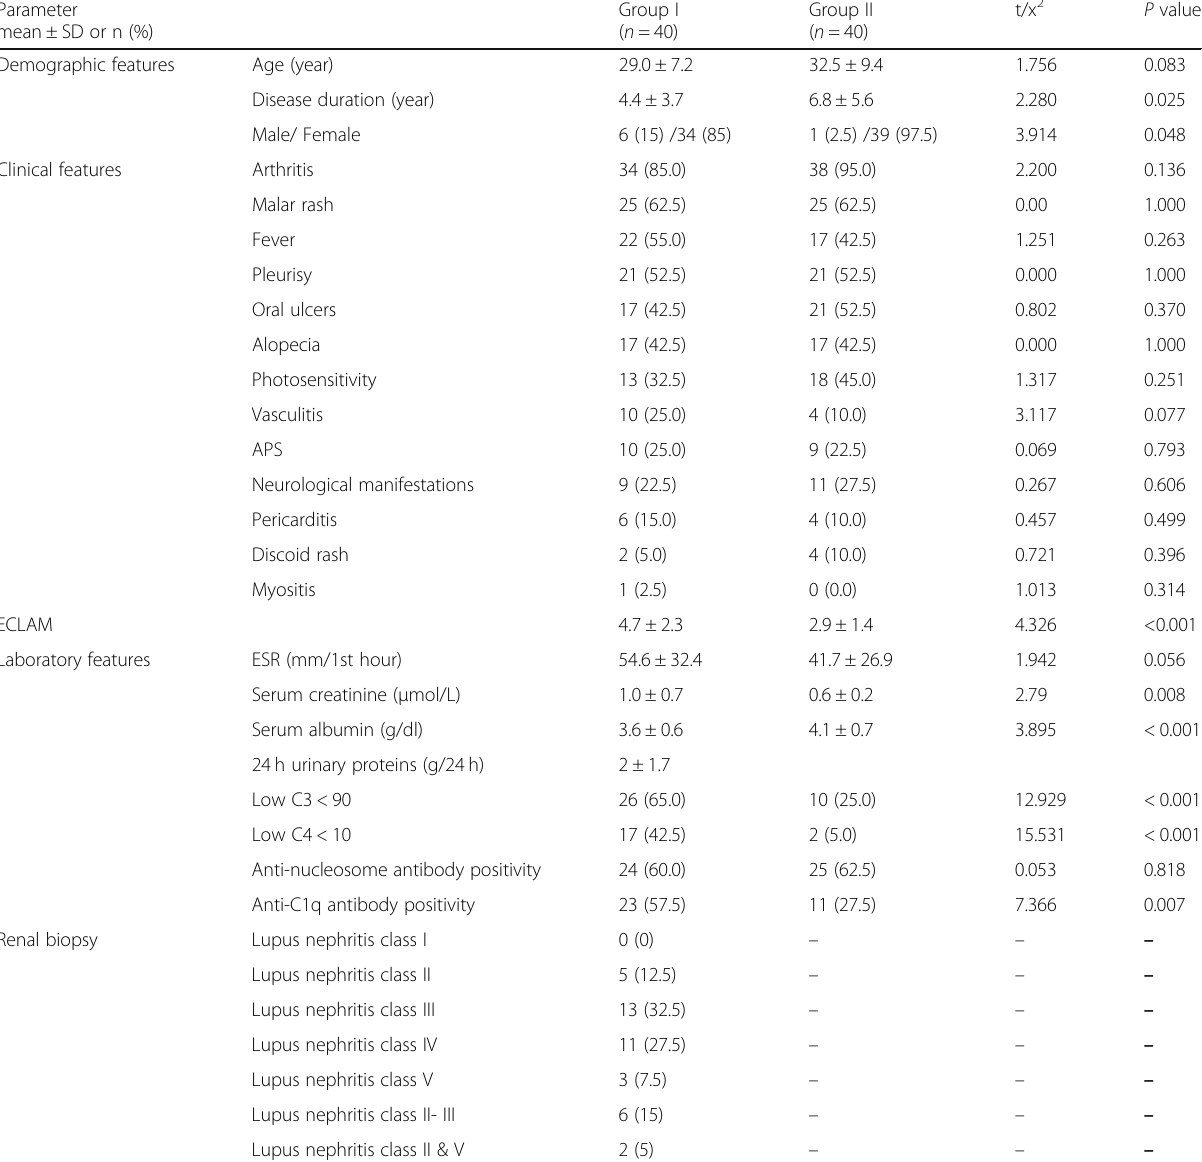
Table 1 Comparison between both SLE groups (with and without LN) regarding demographic, laboratory and clinical characteristics Parameter mean ± SD or n